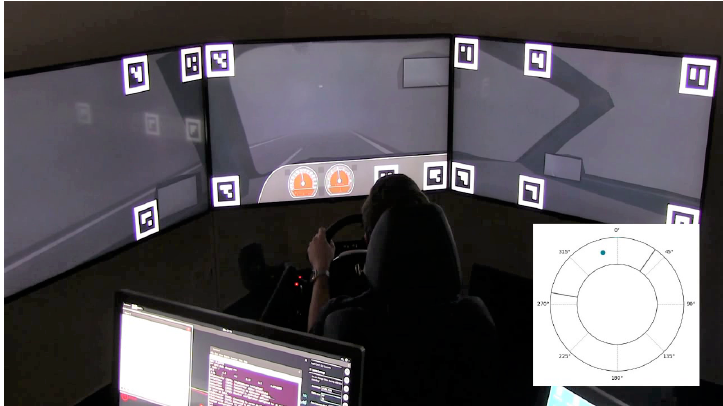
Figure 1. Driving simulator setup in the foggy tunnel scenario. The experimenter screen (bottom left) shows a visualization of the tactile stimuli. In this visualization (magnified in the white box on the right side) the location of a dark dot corresponds to the current direction communicated via a tactile stimulus and the size of the dot indicates the intensity of the respective stimulus. Black bars mark the boundaries between which stimuli oscillate dependent on the current range of spatial uncertainty. This visualization was not available to